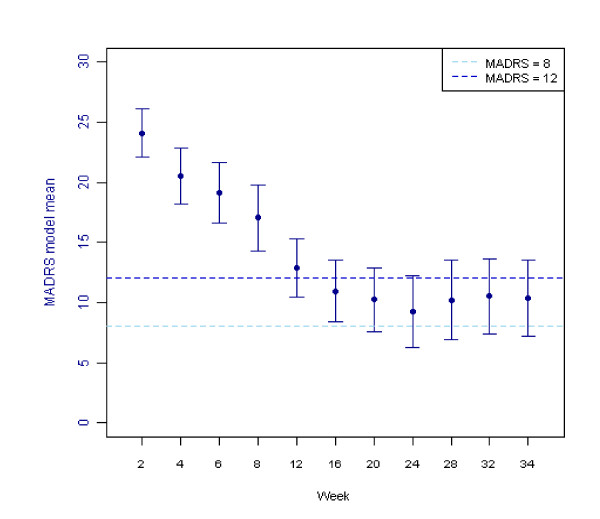
MADRS scores over time, completers (n = 42). The fitted mean and 95% confidence intervals were estimated using a repeated measures analysis of covariance (ANCOVA). The fitted model included terms for time, gender age group and history of anxiety as factors, with the baseline Montgomery-Asberg Depression Rating Scale (MADRS) score and baseline body mass index (BMI) fitted as covariates.